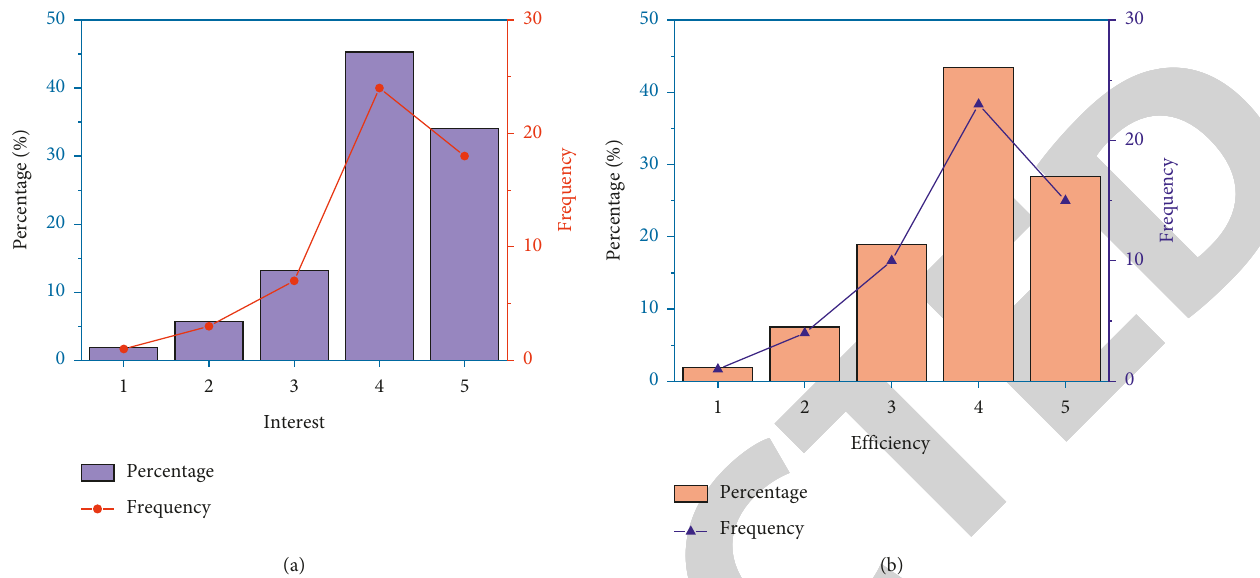
Figure 4: Percentage of learning interest and efficiency after multimedia-assisted teaching. (a) Interest. (b)